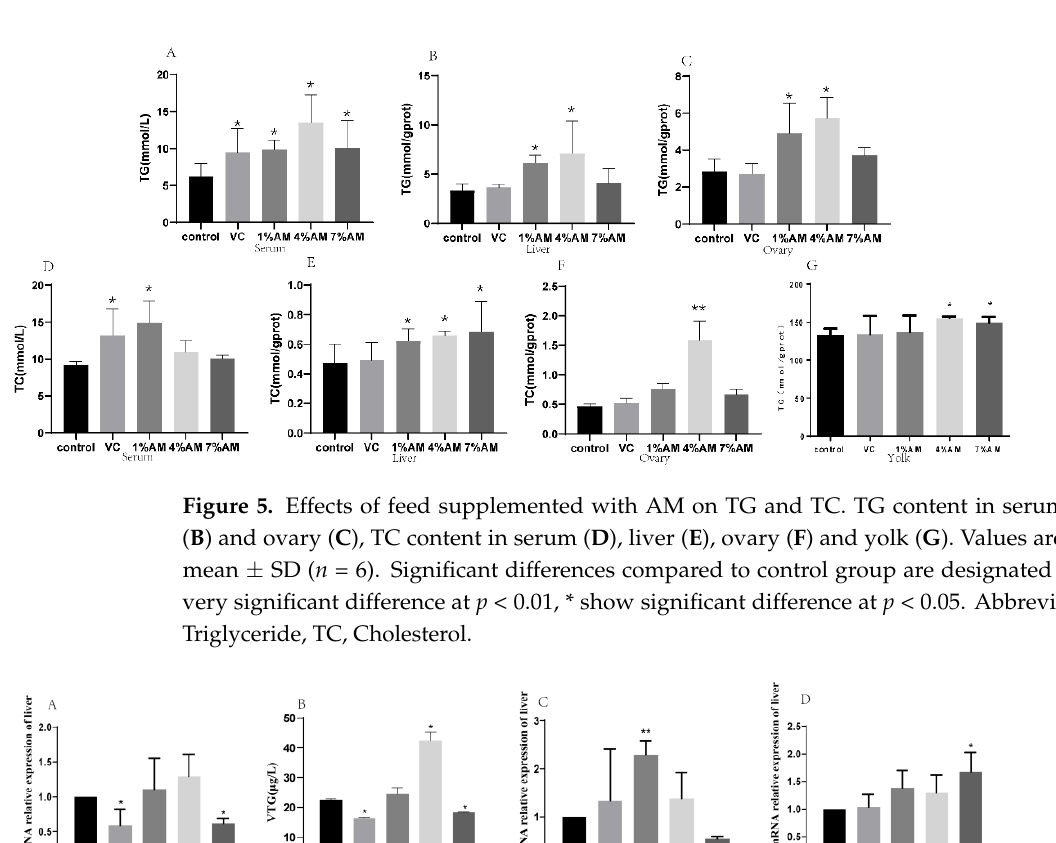
Table 3. Diameters and mass of hierarchical of laying hens.